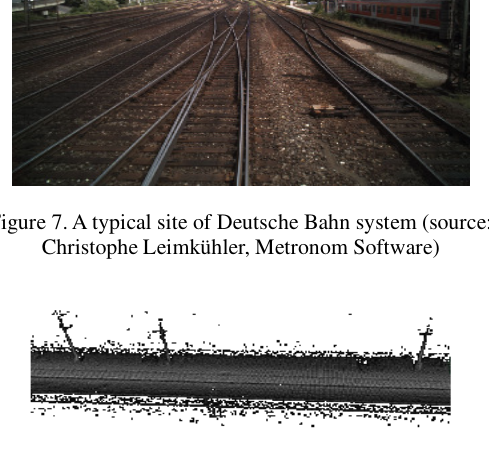
Figure 8. The 3D scan data of the